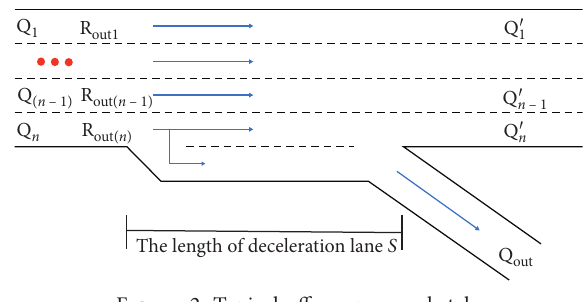
Figure 2: Typical off-ramp area sketch.